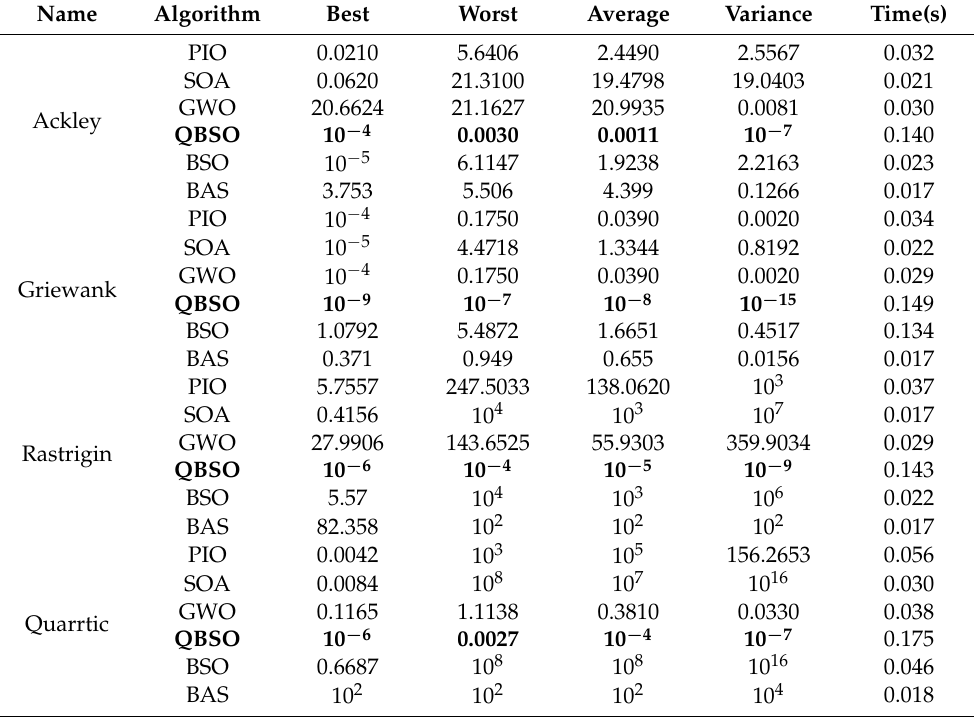
Table 5. Results of the multimodal benchmark function experiments (population size = 30).